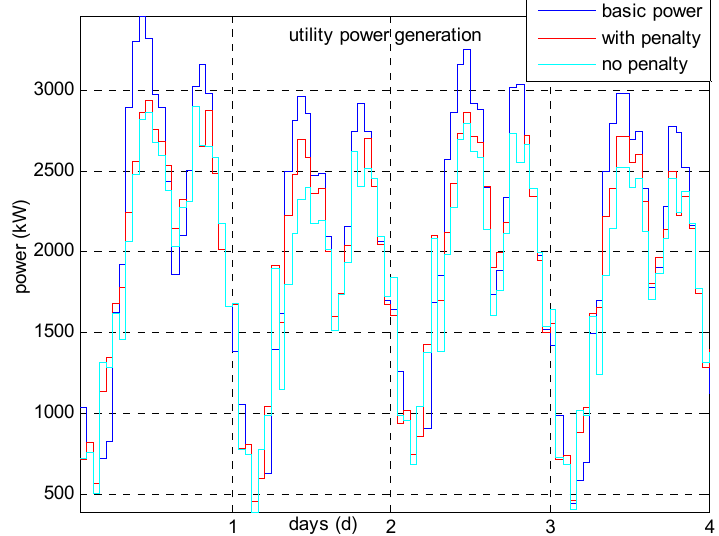
Figure 6. Power generation of the utility with or without considering penalty cost terms.